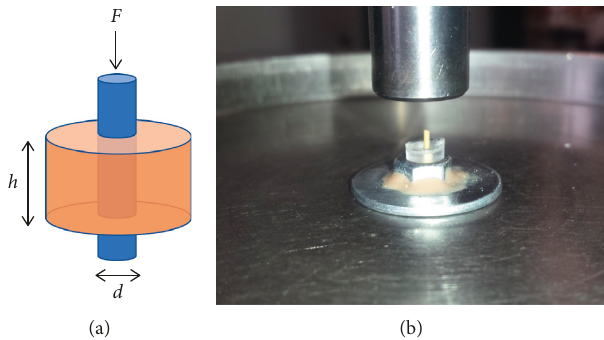
Figure 2: (a) An illustration of the push-out test sample; h is the thickness of the epoxy resin disc and d is the diameter of the fibre. 10mm long fibres were embedded into the epoxy disc with a diameter of 10mm. (b) Mounted sample in the test rig prior to push-out